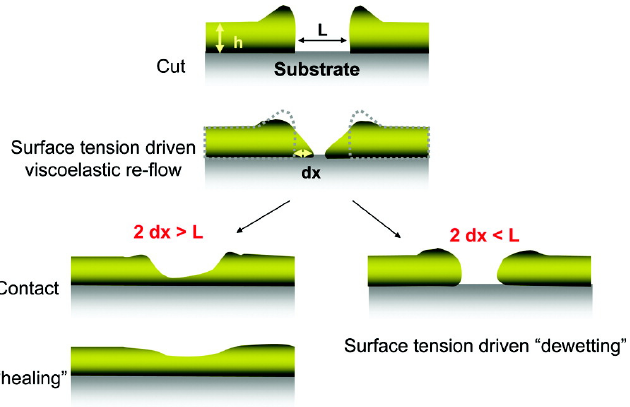
Figure 14. Proposed self-healing mechanism for SS crosslinked polyEGDA-polyBA stars. Reprinted with permission from [84]. Copyright (2012) American Chemical Society.